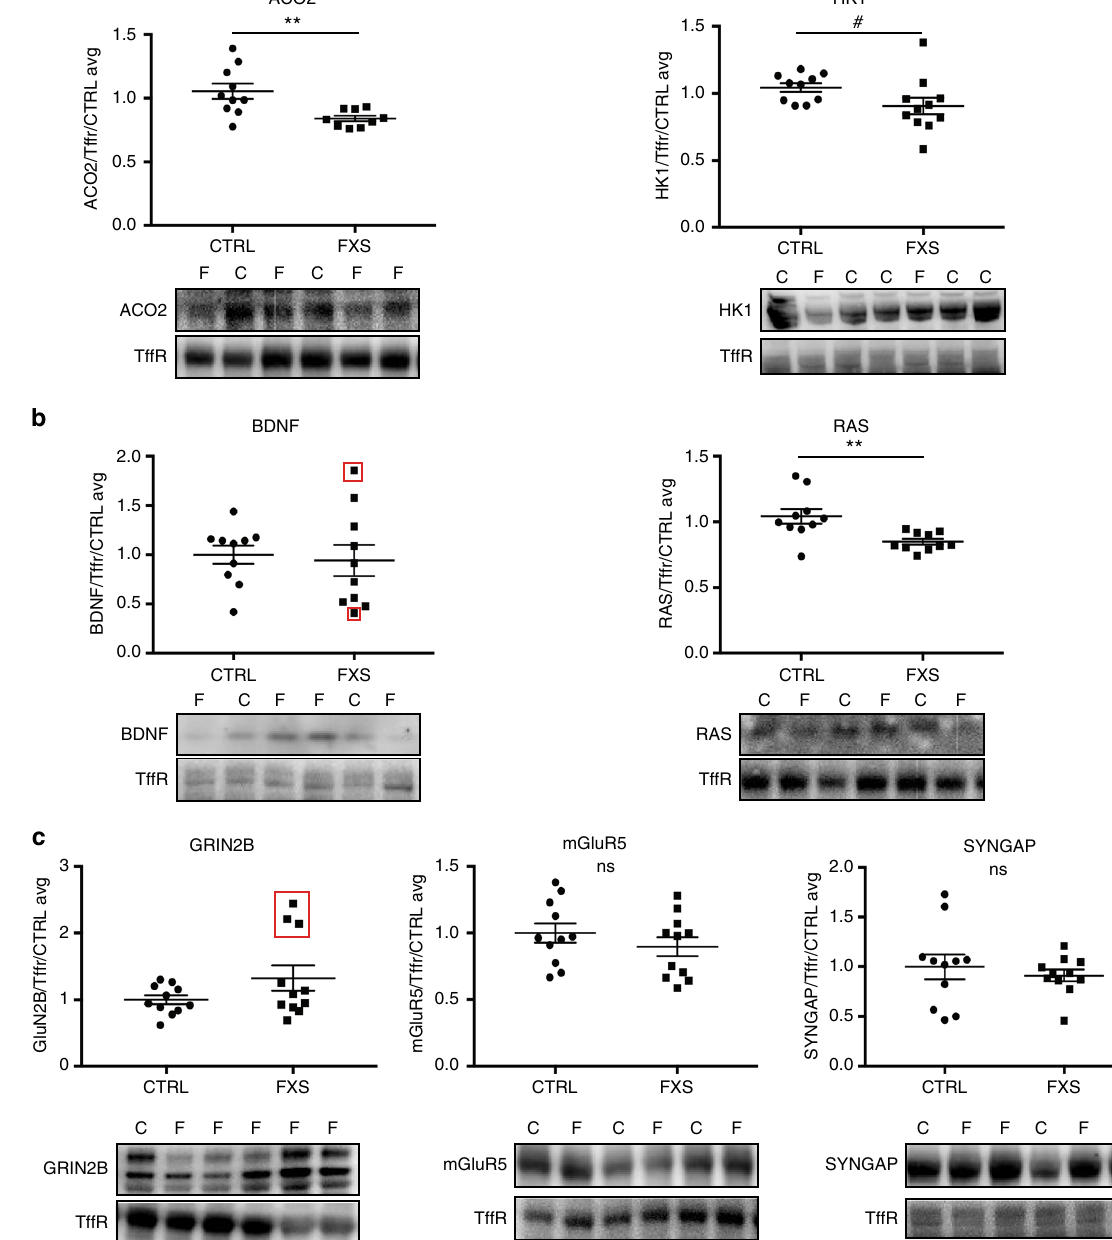
Fig. 5 Several BONLAC candidate proteins have altered abundance in human FXS patient plasma. a Quanti fi cation and western blots of proteins in the biosynthesis pathway in the plasma of healthy human volunteers (CTRL) versus age-matched FXS patients (FXS) * denotes p < 0.05, # denotes p < 0.10. n = 11/group ACO2 p = 0.006, HK1 p = 0.07. b Quanti fi cation and western blots of proteins in the cell membrane/intracellular signaling pathway in the plasma of CTRL versus FXS. n = 11/group BDNF p = 0.35, RAS p = 0.007 c Quanti fi cation and western blots of proteins in the Synapse pathway in the plasma of CTRL versus FXS. n = 11/group GRIN2B p = 0.13, mGluR5 p = 0.32, SYNGAP p = 0.76. All blots use transferrin receptor as the loading control for normalization. One dot = one patient or volunteer. Statistical signi fi cance was determined using a Student ’ s t -test, the absence of a * or # indicate that the groups are not signi fi cantly different. n = 11 per group. All graphs are represented as mean ± SEM. Red boxes indicate values that are 2 + standard deviations outside of CTRL